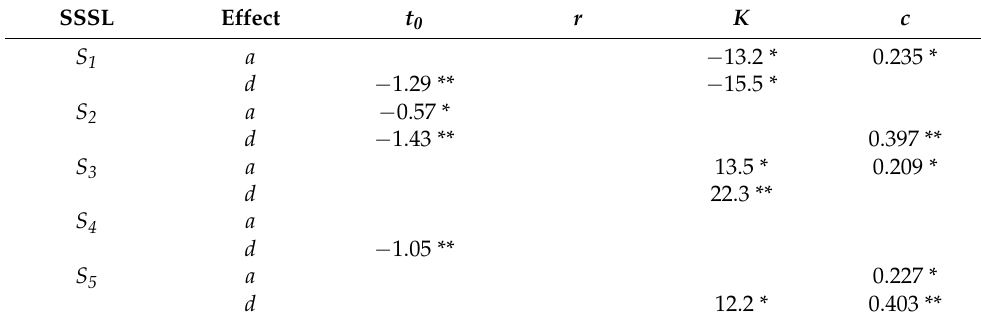
Table 6. QTL effects of the four functional parameters on the leaf numbers. SSSL is an abbreviation of single-segment substitution line. S i represents the homozygote or heterozygote ith SSSL. The additive effect ( a ) or dominant effect ( d ) of the QTLs was estimated by the mean of ( S i − HJX 74 ) , where HJX 74 is an abbreviation of Huajingxian 74. t 0 , r , K , and c are the optimum time, the growth rate, the maximum value, and the degradation rate, respectively. “ − ” indicates descending parameters due to alleles from the donors. * and ** indicate significance at the 5% and 1% levels, respectively.